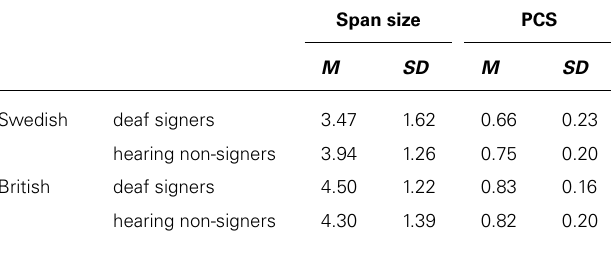
Table 1 | Span size and proportion correct scores (PCS) for operation span performance in experiments 1 (Swedish participants) and 2 (British